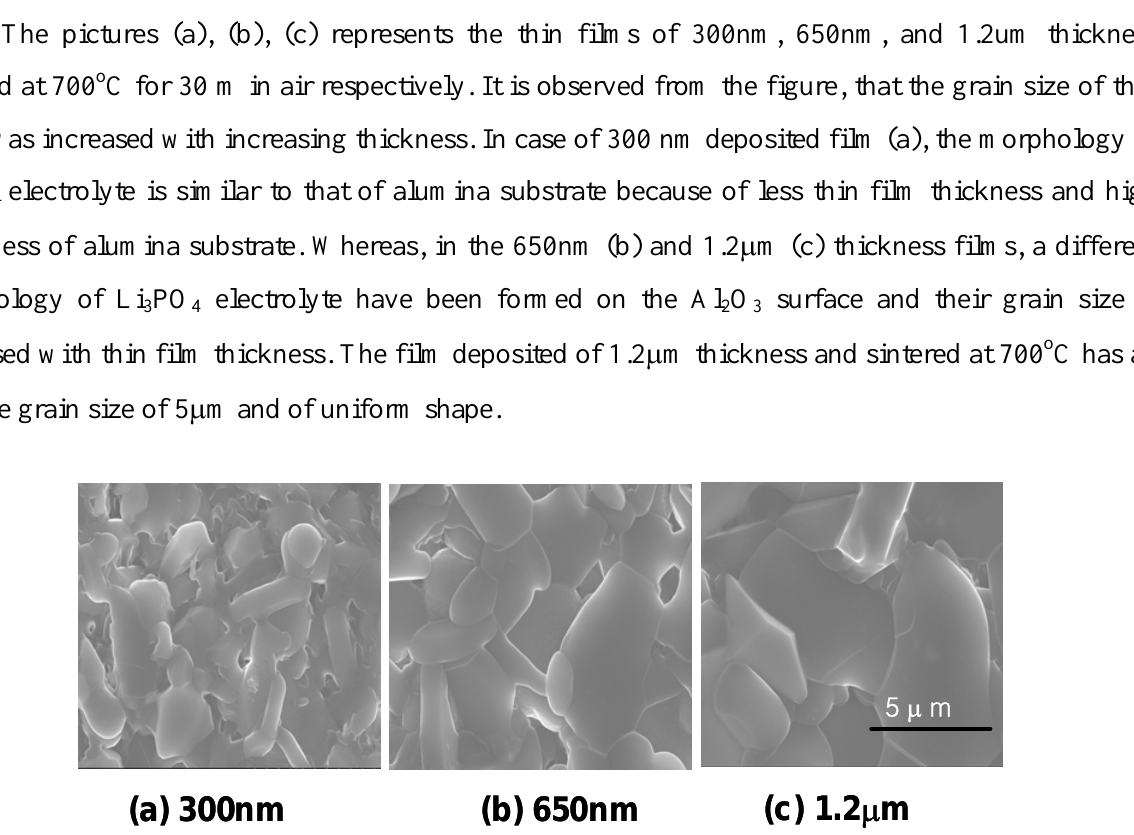
Figure 2. SEM micrographs of the surface morphology of Li (a) 300nm, (b) 650nm, and (c) 1.2 µ m and sintered at 700 o C for 30 m in